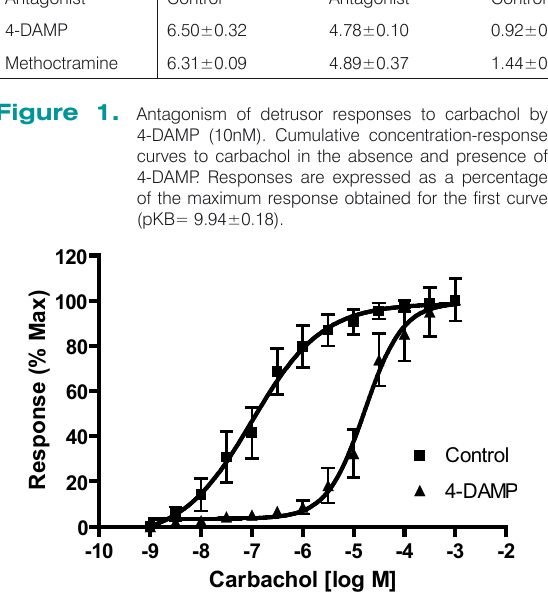
Figure 1. Antagonism of detrusor responses to carbachol by 4-DAMP (10nM). Cumulative concentration-response curves to carbachol in the absence and presence of 4-DAMP. Responses are expressed as a percentage of the maximum response obtained for the first curve (pKB= 9.94±0.18).